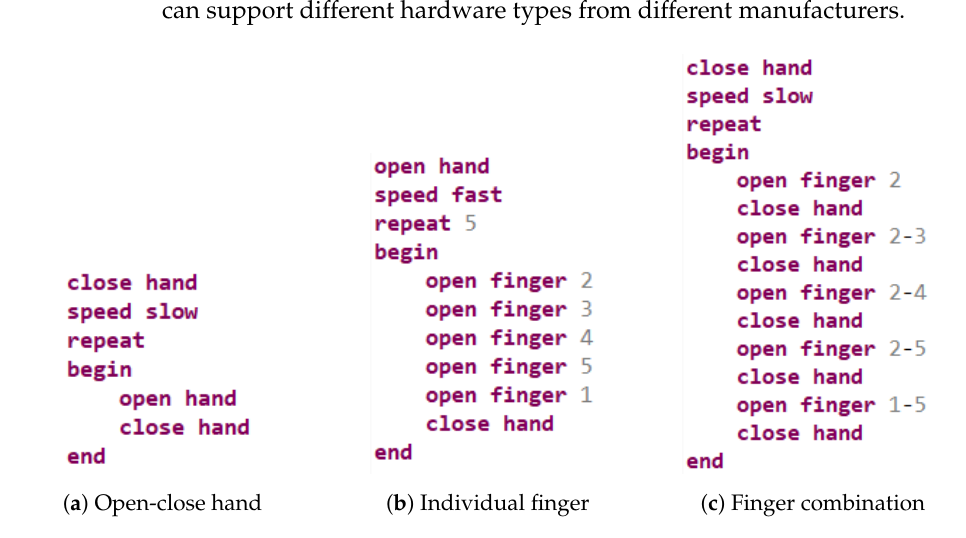
Figure 4. Different exercises for hand